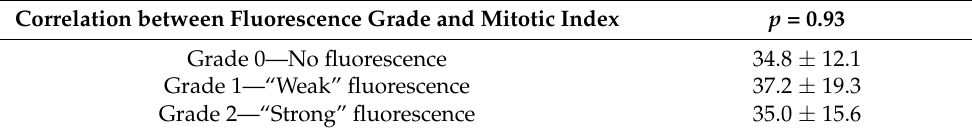
Table 2. Correlation between fluorescence grade and mitotic index. Correlation between Fluorescence Grade and Mitotic